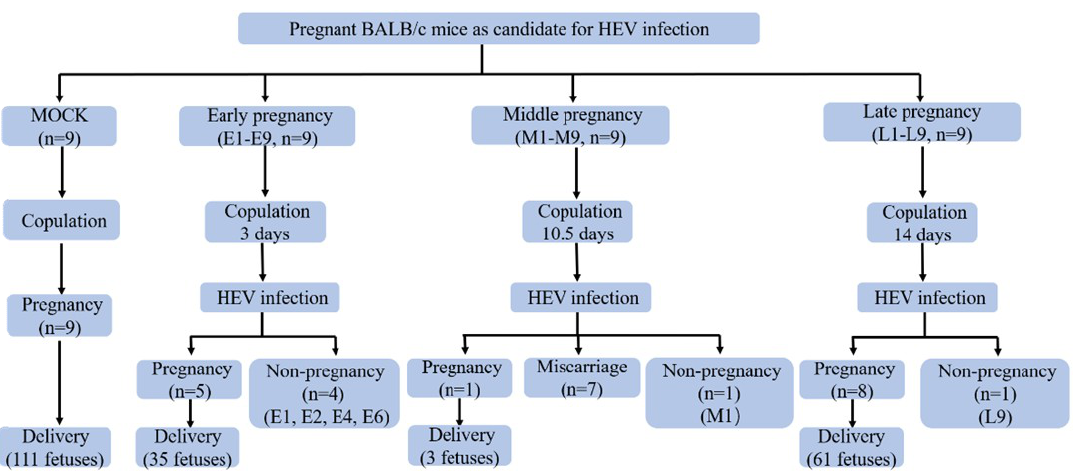
Figure 1. E ff ects of Hepatitis E virus (HEV) infection in the pregnant BALB / c Figure 1. Effects of Hepatitis E virus (HEV) infection in the pregnant BALB/c mice.